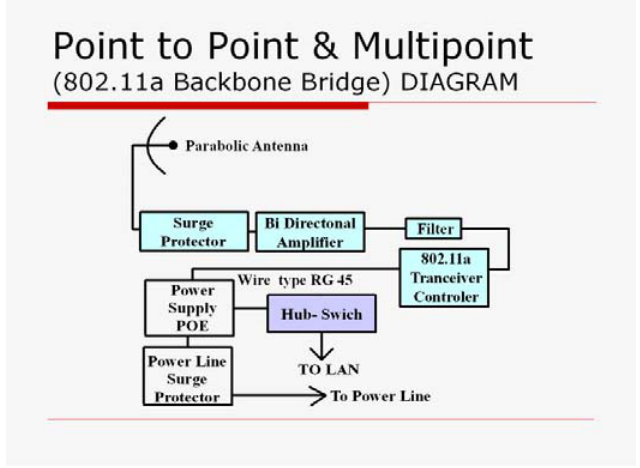
Figure 5. Point to point Backbone Bridge